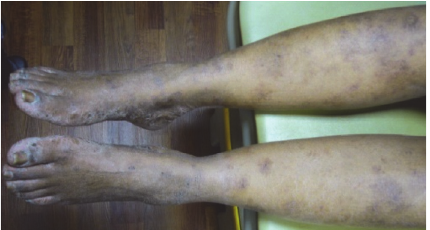
Figure 1: Acrokeratosis paraneoplastica . Of note, the patient had scaly hyperpigmented plaques on the ulnar surfaces of the bilateral hands and the periungual skin of the fingers, with some fissuring, as well as irregular pitting of the right fifth fingernails.